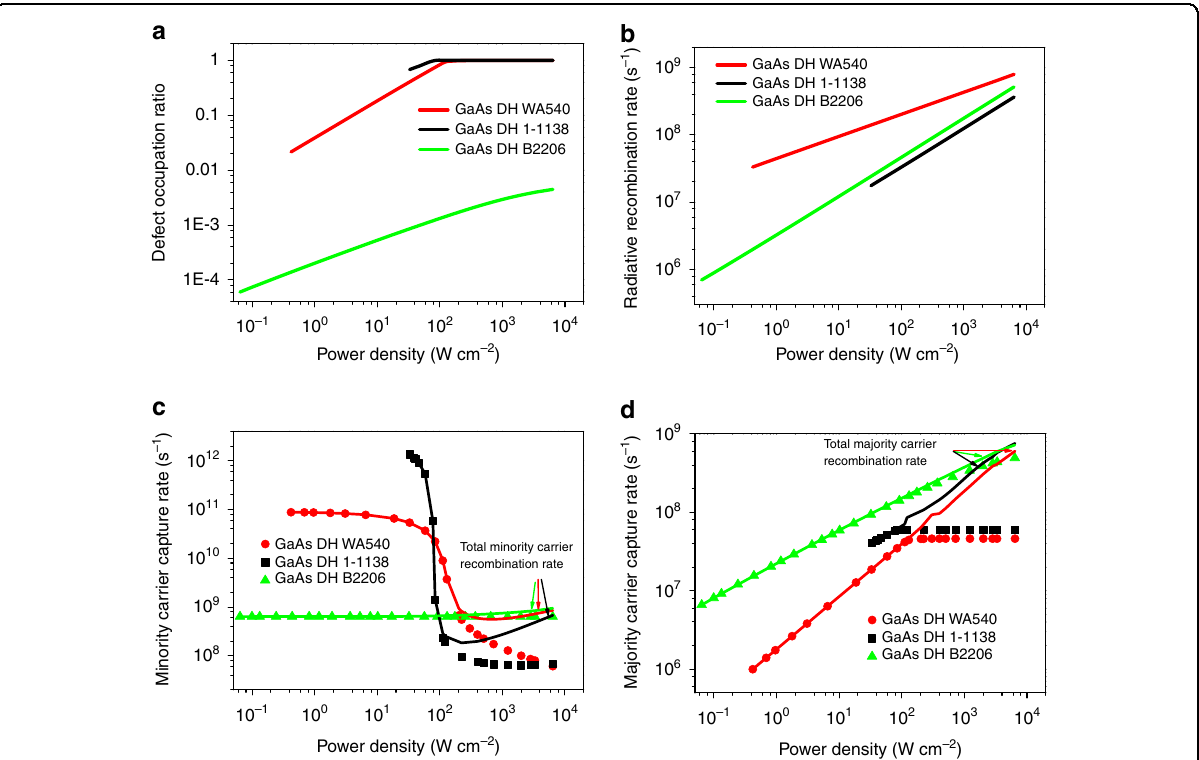
Fig. 3 Derived transition rates for all GaAs samples under 10× lens. a Defect center occupation fraction, b Inter-band radiative recombination rate W r , c minority carrier defect capture rate W nr (symbols) and total recombination rate W (solid lines), and d majority carrier defect capture rate R t (symbols) and total recombination rate R (solid